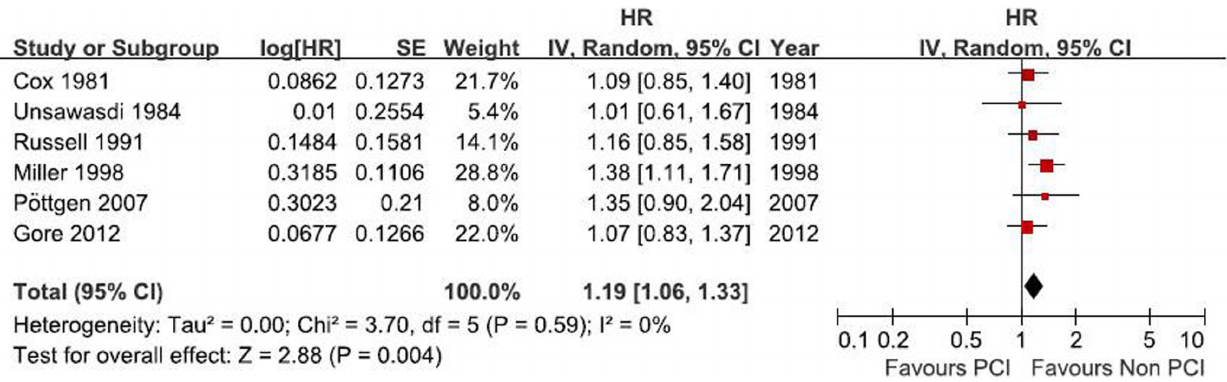
Figure 4. Results of the funnel plot of the studies evaluating the effect of PCI on brain metastases: OR, Odds ratio.